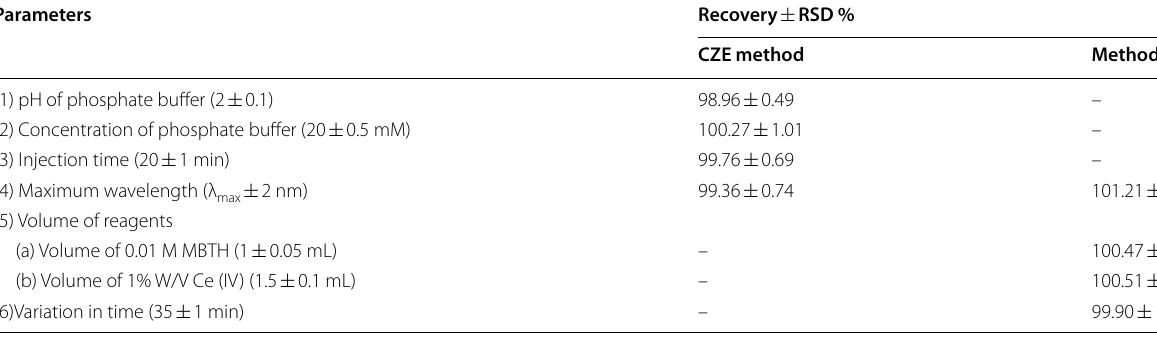
Table 4 Robustness evaluation for the analysis of TIG in intravenous infusion solution using the proposed methods Parameters